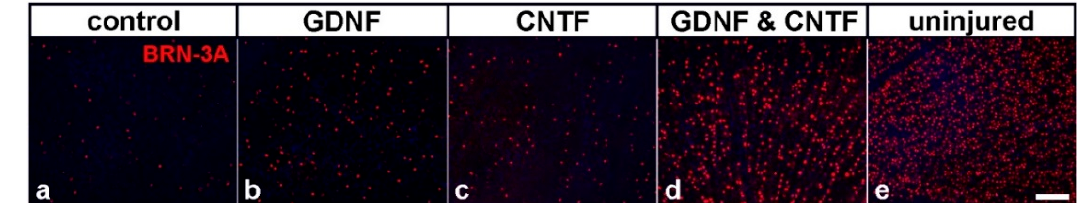
Figure 1. Intravitreally co-grafted GDNF- and CNTF-overexpressing neural stem cells synergistically promote the survival of RGCs in a mouse optic nerve crush model over an extended period of time. RGCs were stained with anti-BRN3A antibodies in retinal flatmounts eight months after an intraorbital optic nerve crush and intravitreal cell transplantation ( a – d ). The density of RGCs in eyes with grafted GDNF- ( b ) or CNTF- ( c ) overexpressing cells was similar and significantly higher than in eyes with grafted control cells that expressed a fluorescent reporter protein only ( a ). Note the pronounced rescue of axotomized ganglion cells in animals that had received co-transplantations of the GDNF- and CNTF-overexpressing cell lines ( d ). A retinal flatmount from a healthy, uninjured animal is shown for comparison ( e ). Bar: 50 µm. Figure adapted from Dulz et al. (2020).